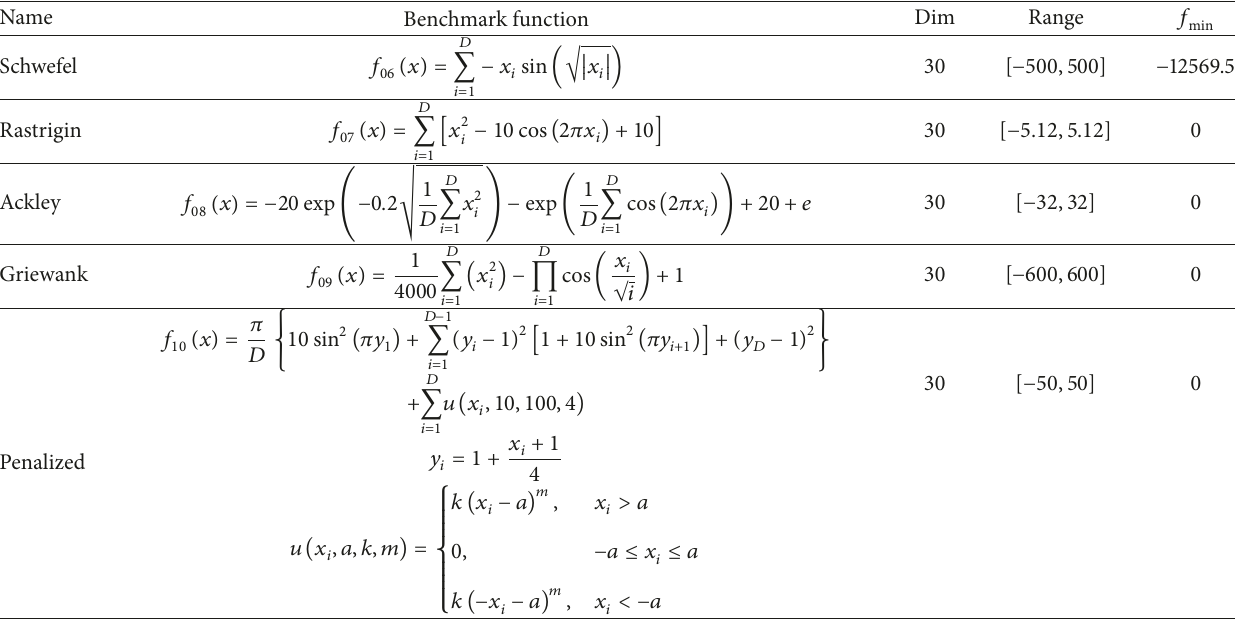
Table 2: Multimodal benchmark functions.